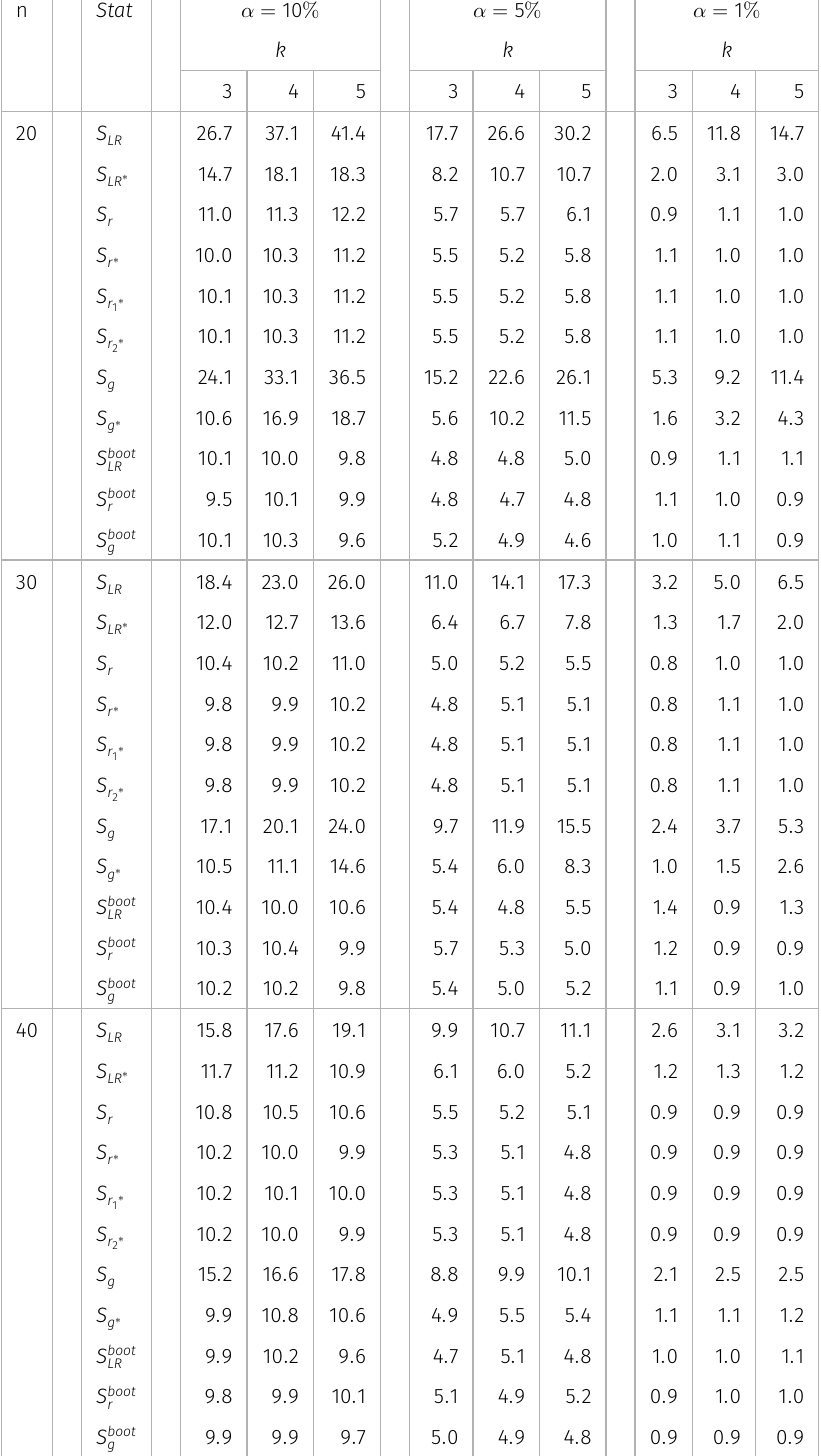
∶ 𝛿 = … = 𝛿 = 0 with p = 3 ; t 0 1 k